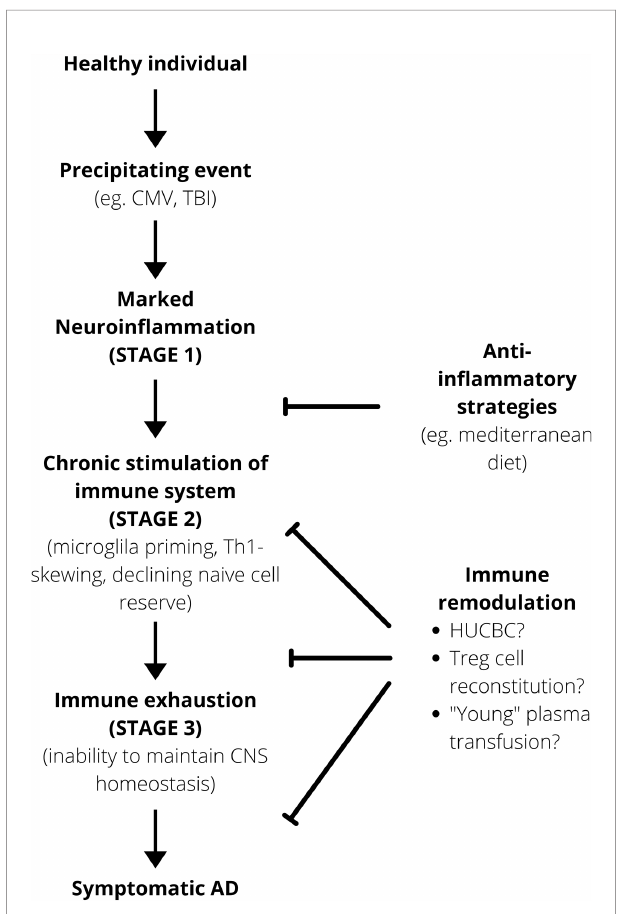
FIGURE 2 | Working model for AD pathogenesis. Anti-in fl ammatory strategies are important prophylactically to minimize that risk of the immune system progressing onto a self-perpetuating path towards immunosenescence. After a certain point, immune remodulation is required to alter the disease course. HUCBC, Human Umbilical Cord Blood